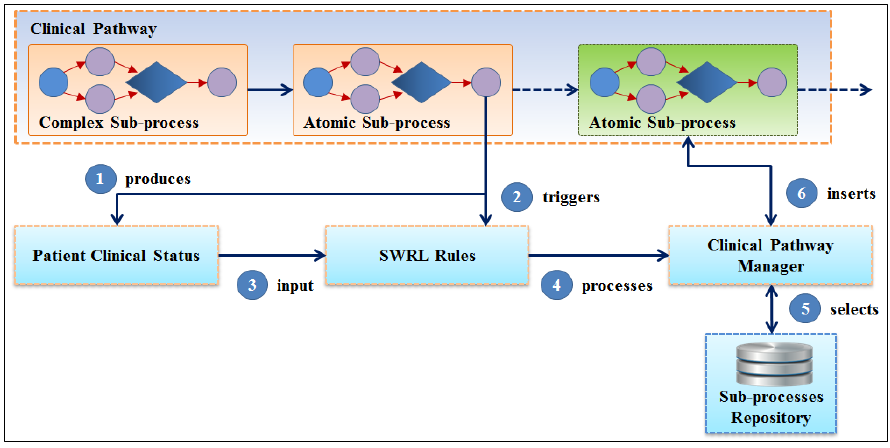
Figure 1. SEMPATH adaptation methodology